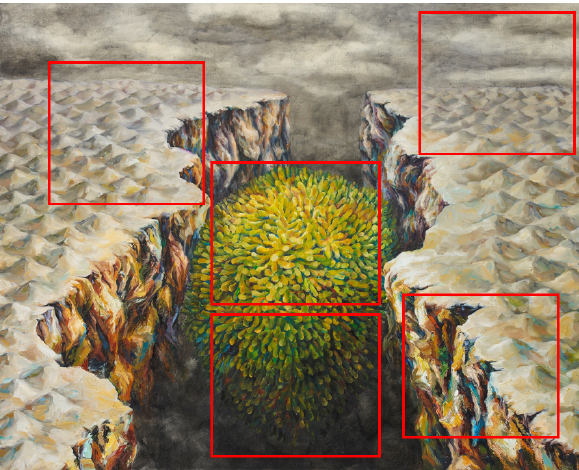
Figure 4. A painting by Jiho Lee. In Experiment 1, we captured key parts of each painting, not the whole part.